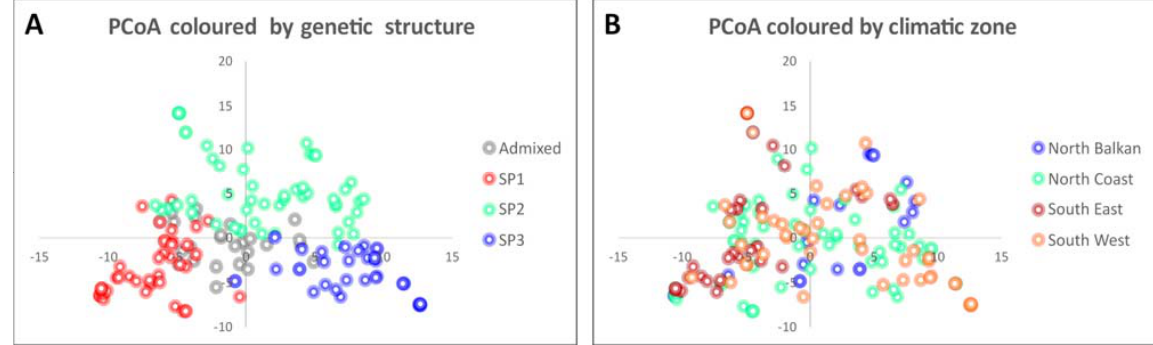
Figure 2. PCoA with a collection of 153 bread wheat Mediterranean landraces based on 10,458 SNPs. The genotypes are coloured based on: ( A ) the genetic structure [12] and ( B ) the climatic zone of the country of origin as defined by Royo et al. [22].